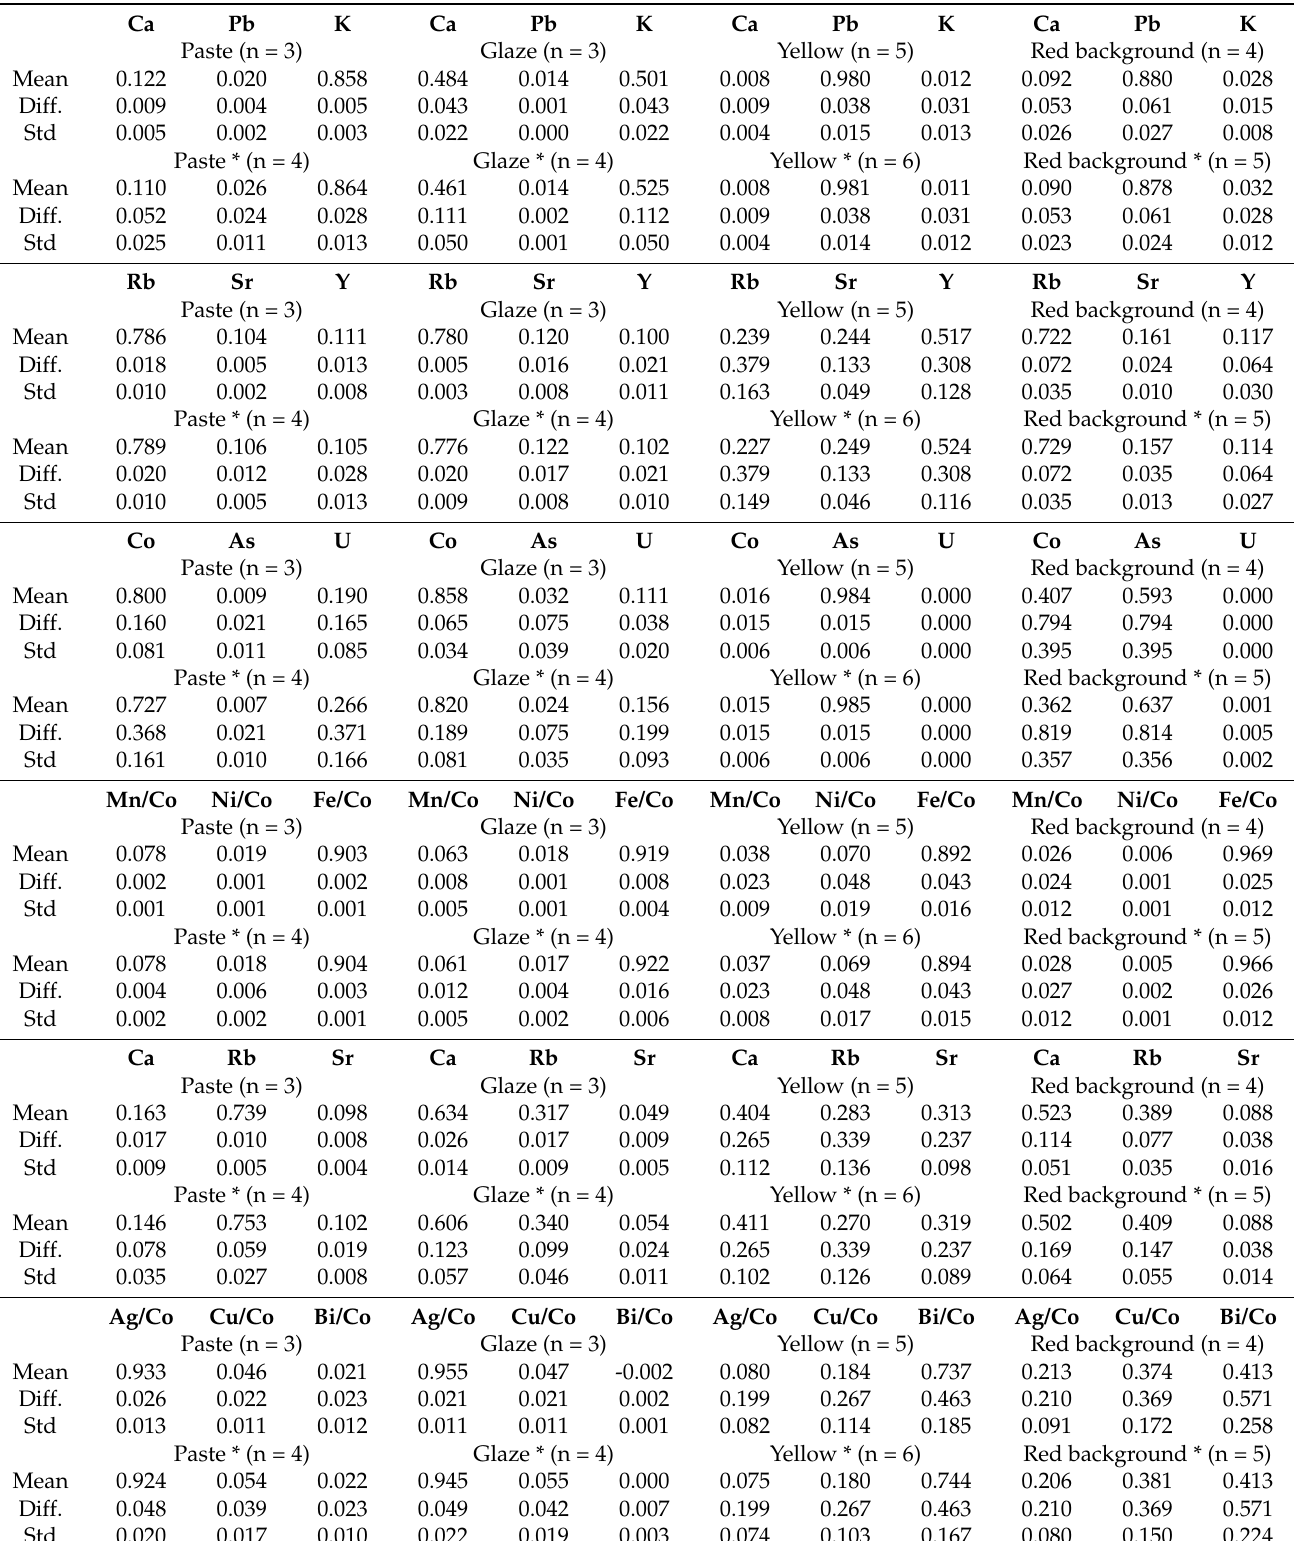
Table 2. Means, differences between maximum and minimum and standard deviation calcu- lated Figures 5 and 6 (std = standard deviation). Details of calculations are given in Table S2 (Supplementary